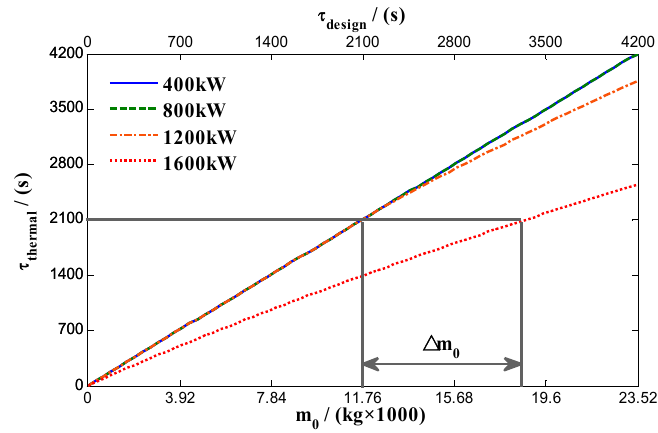
Figure 4. Relationship between m 0 , τ thermal and τ design .